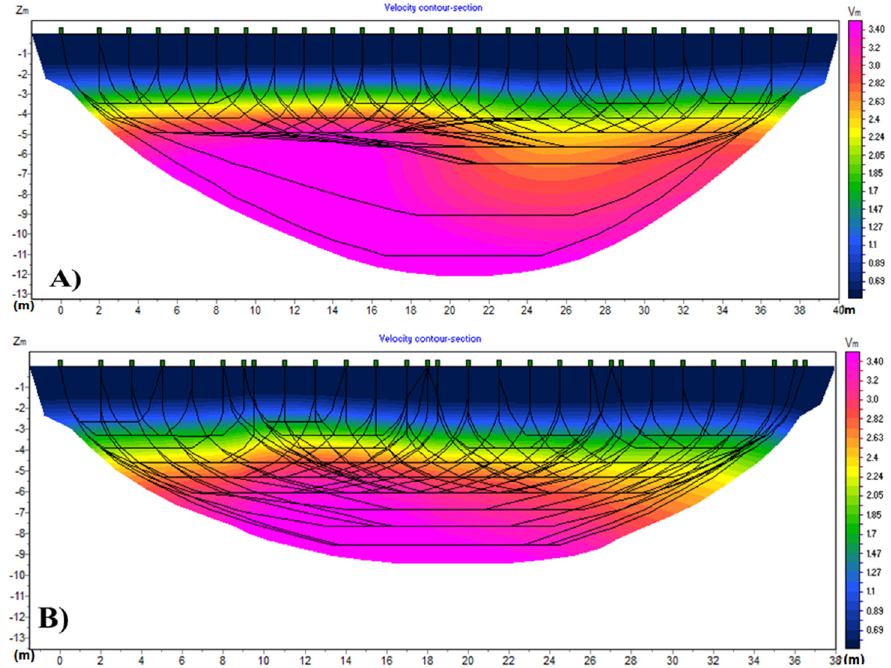
Figure 6. Velocity model derived from the tomographic inversion of the seismic refraction data. A clear drop in velocity is observed with low coverage of rays in the section above the cavity ( A ). While a similar response to the former is observed in the section away from the cavity ( B ), the latter is not.